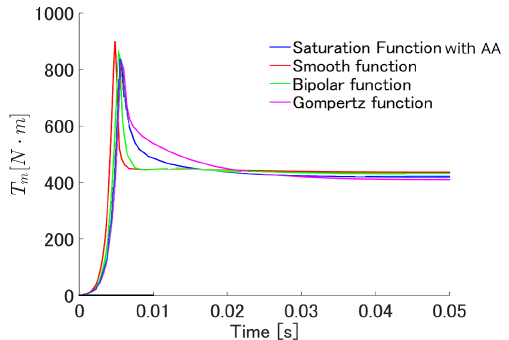
Figure 11. Time response of slip ratio on dry asphalt